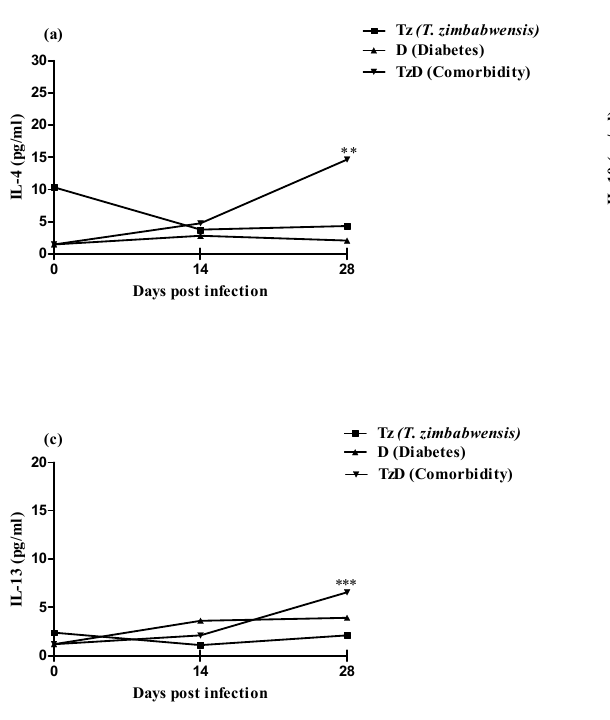
Figure 7. IL-4 concentrations ( a ) IL-10 concentrations ( b ) and IL-13 concentrations ( c ) in male Sprague Dawley rats that were comorbid with type 2 diabetes mellitus (TzD), diabetic (D) and infected with Trichinella zimbabwensis (Tz). Values are presented as mean ± SEM ( n = 6 in each group) and asterisks represent significant differences between the groups (** p < 0.01, *** p < 0.001).